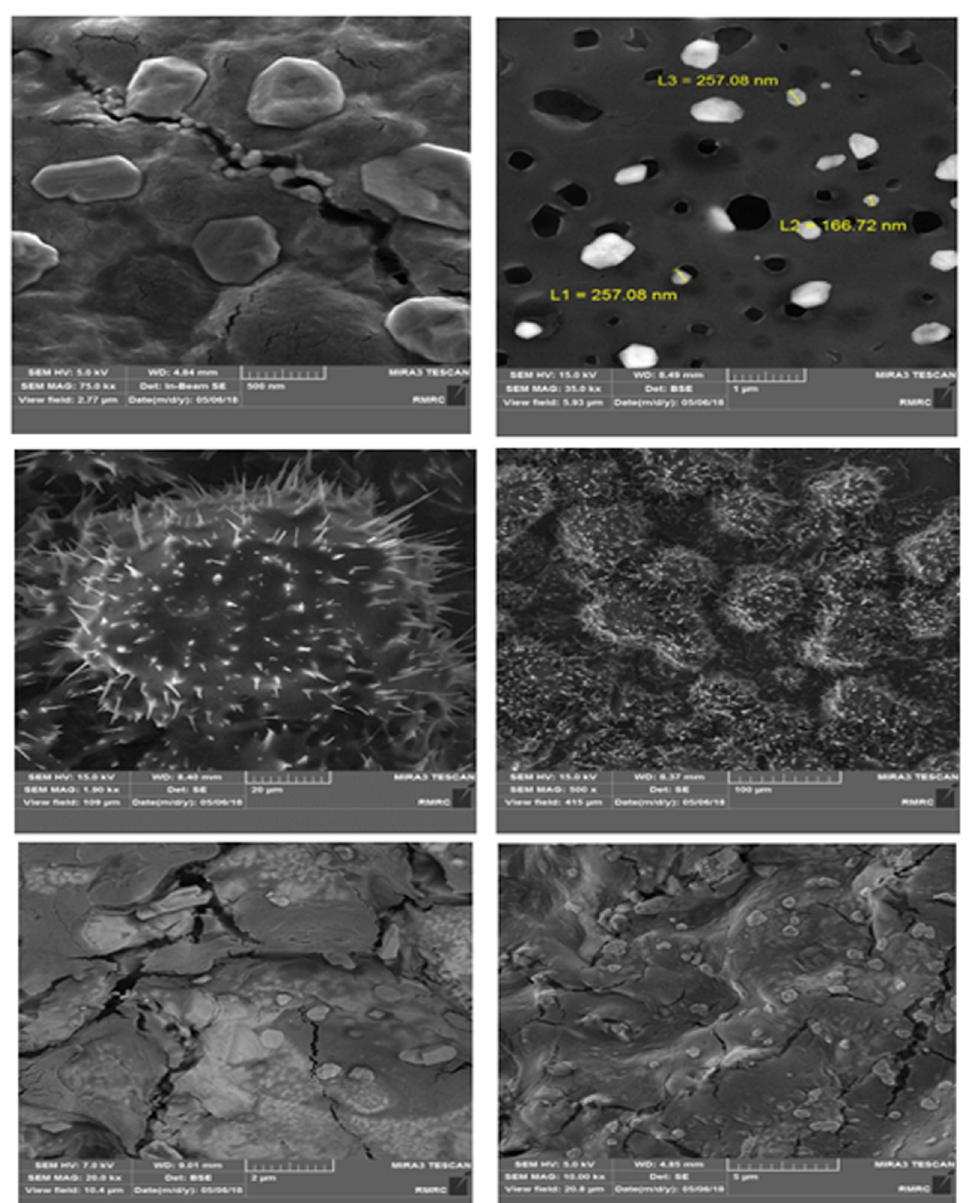
Figure 6: FE - SEM images of the optimum sodium alginate/AAc composite hydrogels conjugated to silver